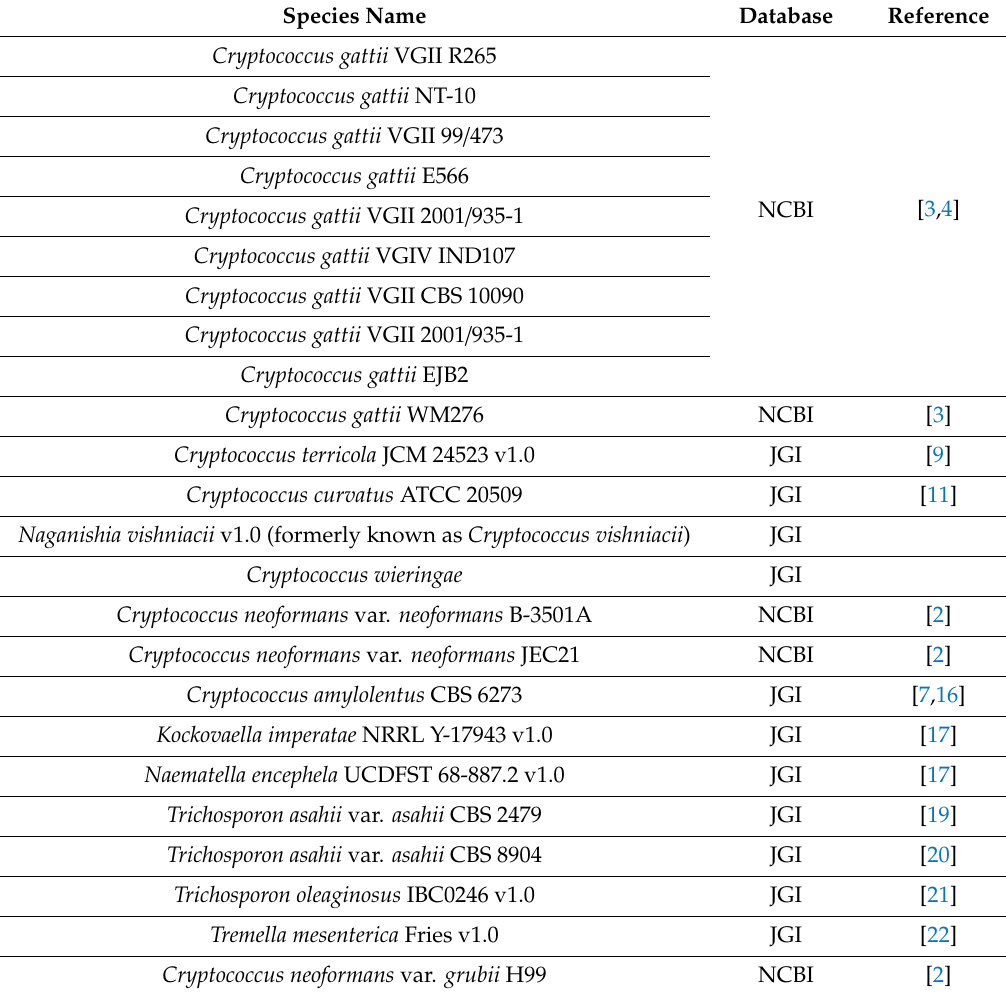
Table 2. Species of Tremellomycetes used in the study. The respective genome databases used for analysis of CYPs, along with the reference articles, are listed in the table. Abbreviations: NCBI, National Center for Biotechnology Information and JGI, Joint Genome